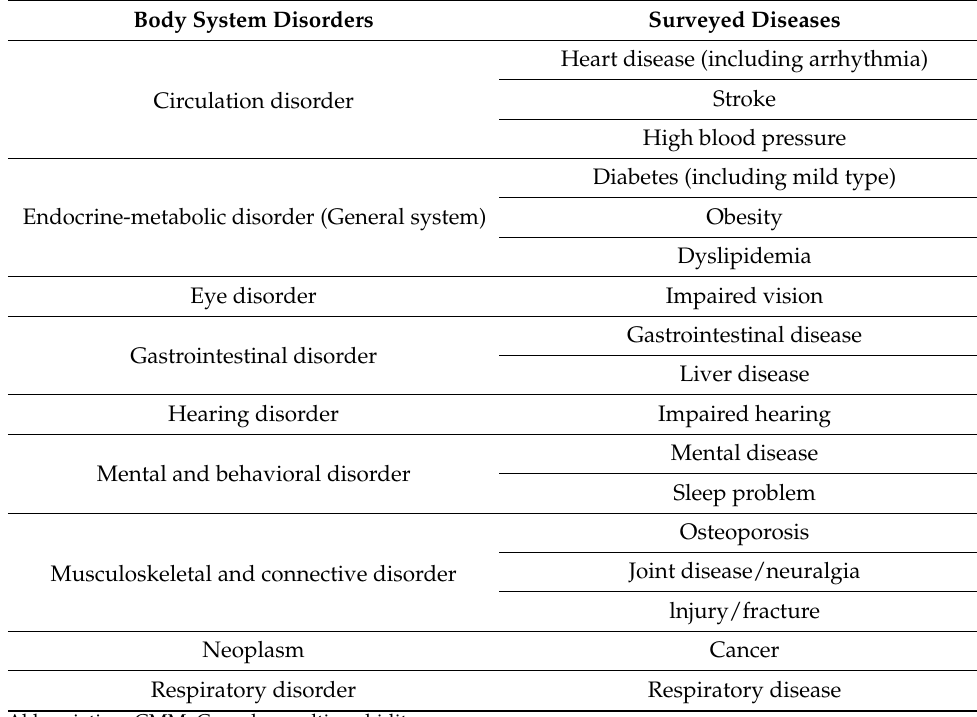
Table 1. Definition of